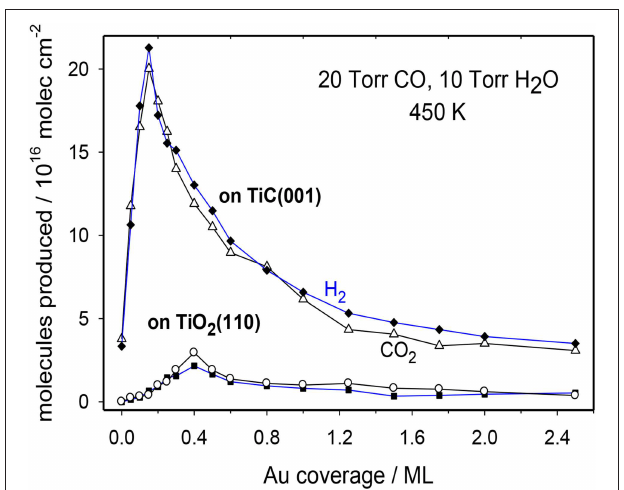
FIGURE 6 | Calculated reaction profiles for the water-gas shift reaction on TiC(001) and Au/TiC(001). The structures for the different intermediates and transition states (A-L) are displayed in Figure 7 . Reproduced with permission from Rodriguez et al. (2014), copyright 2014 by Wiley.